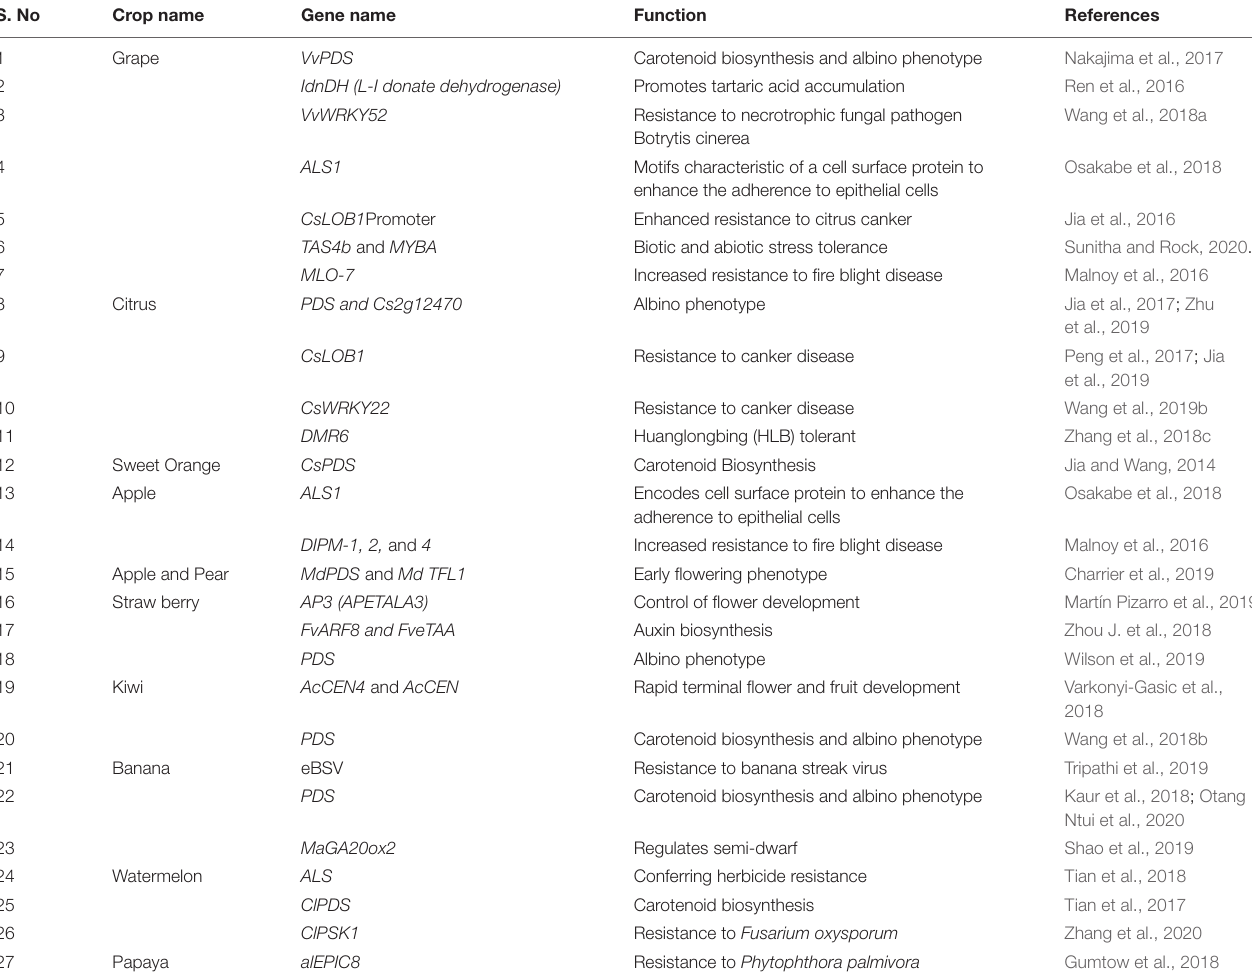
TABLE 1 | Partial list of genes of fruit crops and its specific functions modified via CRISPR/Cas9 system. S.